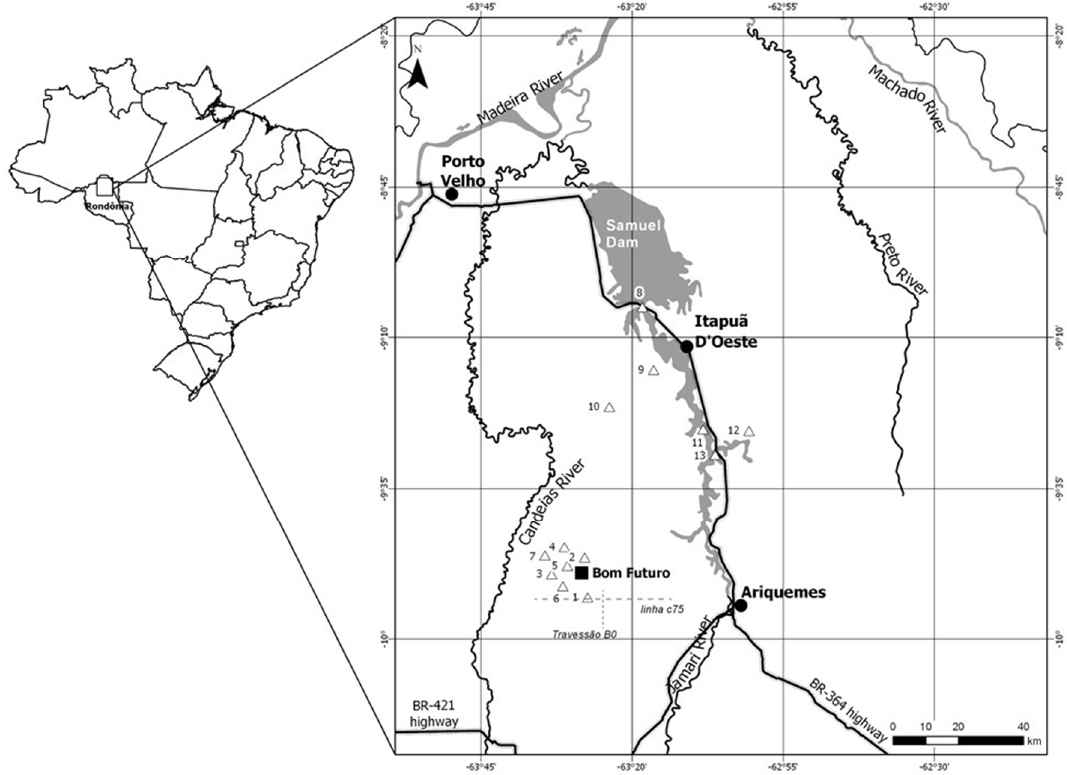
Figure 1. Map of the region showing points of sample collection for the rural localities of Bom Futuro and Itapuã; adapted from Marques et al. [17,18].